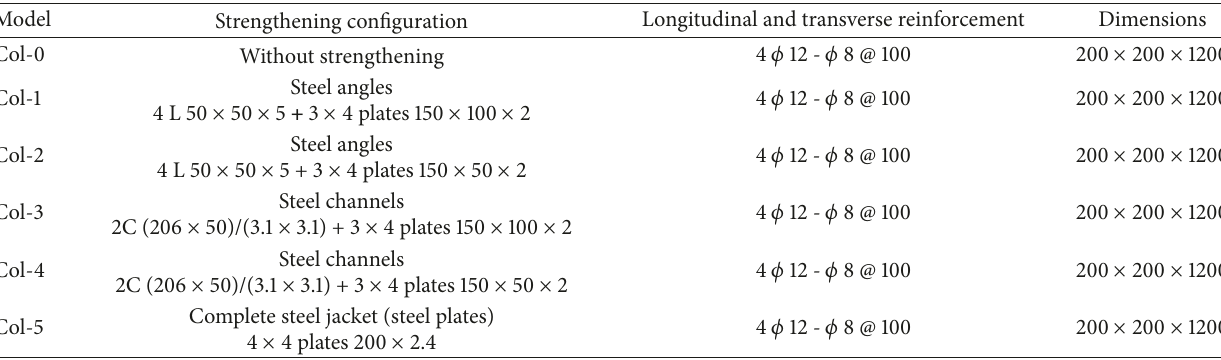
Figure 3: Uniaxial behavior of concrete; (a) tension; (b) compression [15]. Table 1: Specifications of models (dimensions: mm).